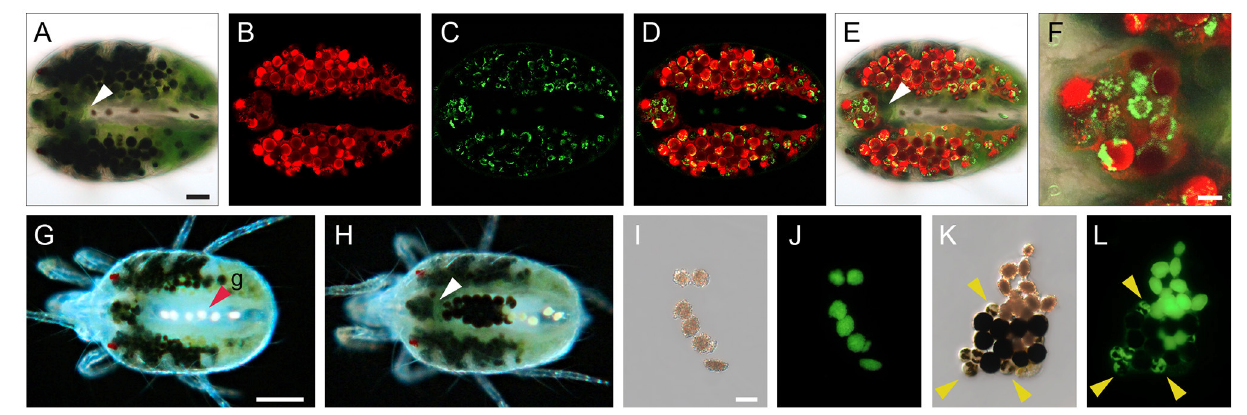
FIGURE 7 | Compartmentalization of digestion and nitrogenous waste in spider mite. (A) Brightfield microscopy of a female spider mite showing characteristic spots produced by large numbers of mature DCs, green pigmentation of midgut lumen and colorless posterior midgut with a few guanine pellets within. White arrowheads point at the boundary between the midgut and the posterior midgut in panels (A, E, H) . (B–D) Confocal images of autofluorescence of (B) chlorophyll, red false color, (C) guanine, green false color, and (D) their overlay within mite midgut lumen, DCs and the posterior midgut. (E) Overlay of images in A–C. (F) Detail, showing distribution of chlorophyll (red) and guanine (green) in DCs in the ventriculus. (G) Guanine pellets (g, red arrowhead) within posterior midgut of female spider mite. (H) DCs and guanine pellets within posterior midgut of female spider mite. (I) Excreted guanine pellets. (J) Autofluorescence of guanine pellets under UV light. (K) Mixed excretion containing guanine pellets and DCs at various stages of development. (L) Autofluorescence of guanine pellets, and guanine deposits within DCs under UV light. Scale bars: (A–E) : 50 µ m; (F) : 10 µ m; (G,H) : 100 µ m; (I–L) : 25 µ